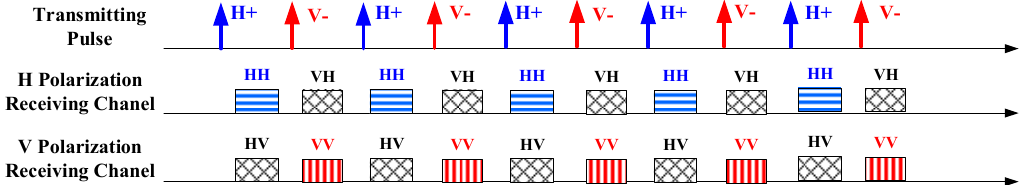
Figure 1. Time-division operation architecture with Inverse modulation slopes.